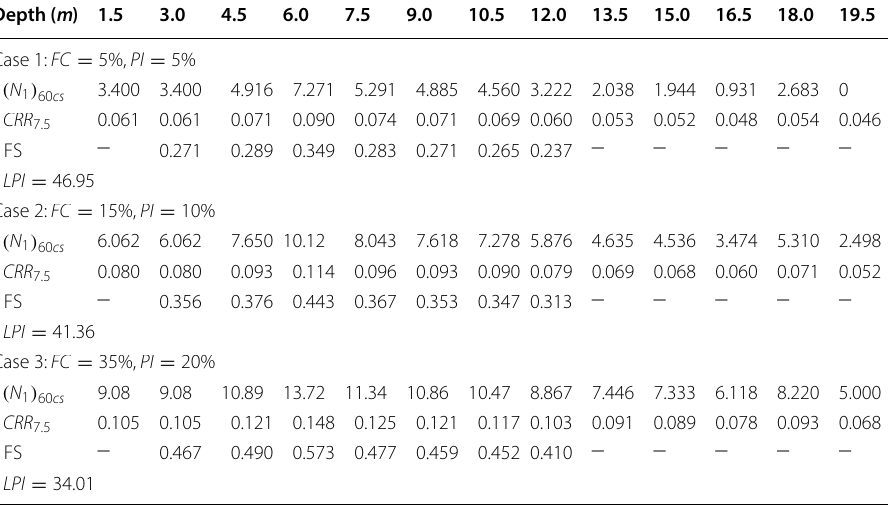
Table 3 Calculation details of LPI through Seed and Idriss [1] method for borehole B-25 Depth ( m )